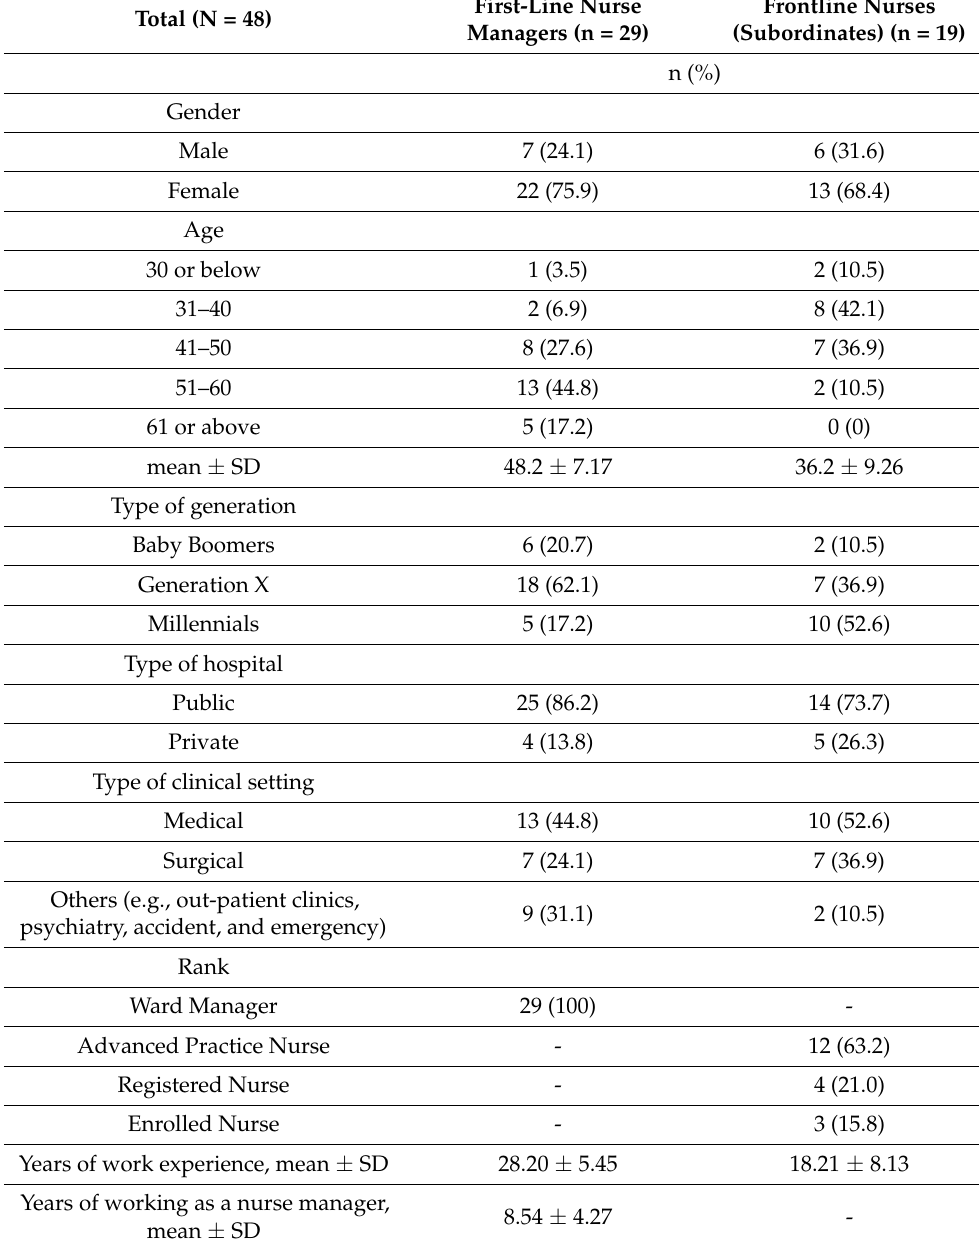
Table 1. Demographic Characteristics of the